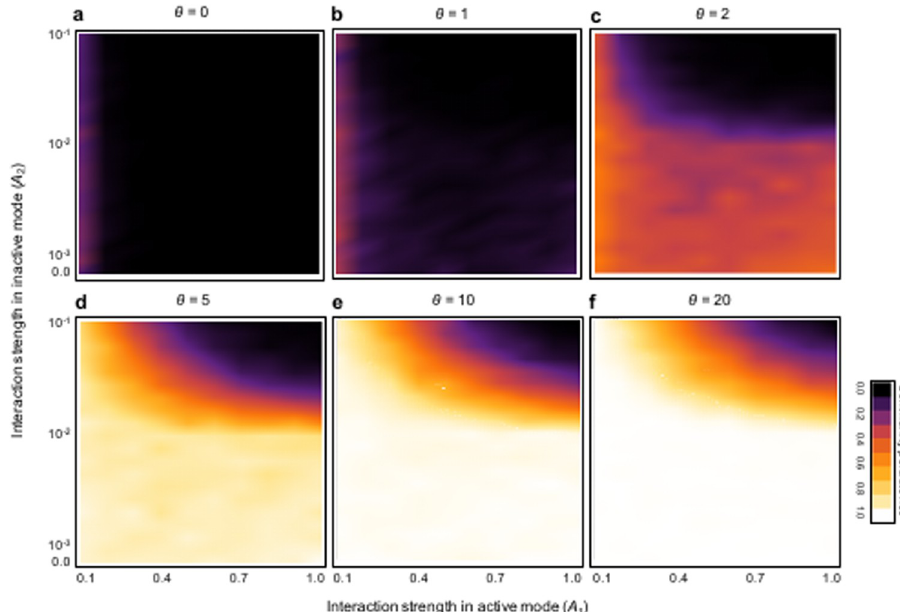
Fig 2. Effects of the interaction strengths of each activity mode on community stability, with the variation of switching accuracy ( θ ). Color represents the level of community stability as shown within panel (f). N = 40 and C = 0.3. Parameters are R = 0.04, E = 0.01, and G =